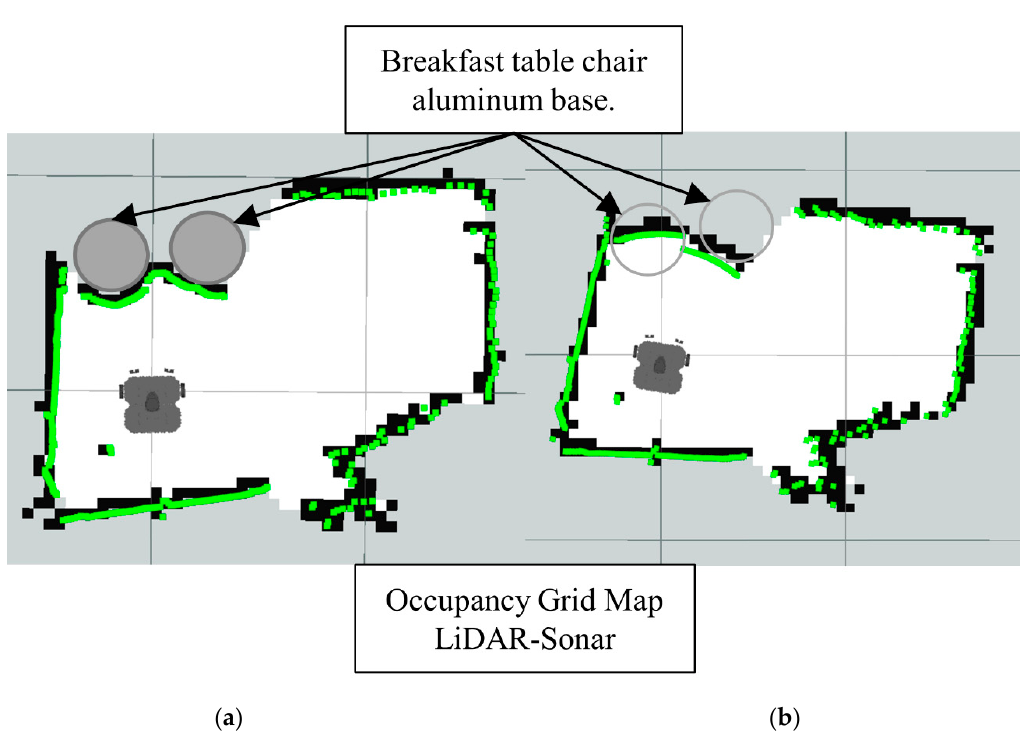
Figure 20. Occupancy grid maps showing the: ( a ) Ground truth (reference map); ( b ) LiDAR-Sonar fusion generated map.